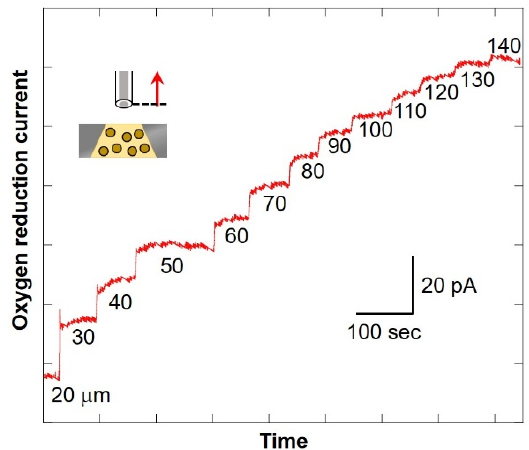
Figure 8. Changes in oxygen reduction current value in the Z ‐ axis direction.